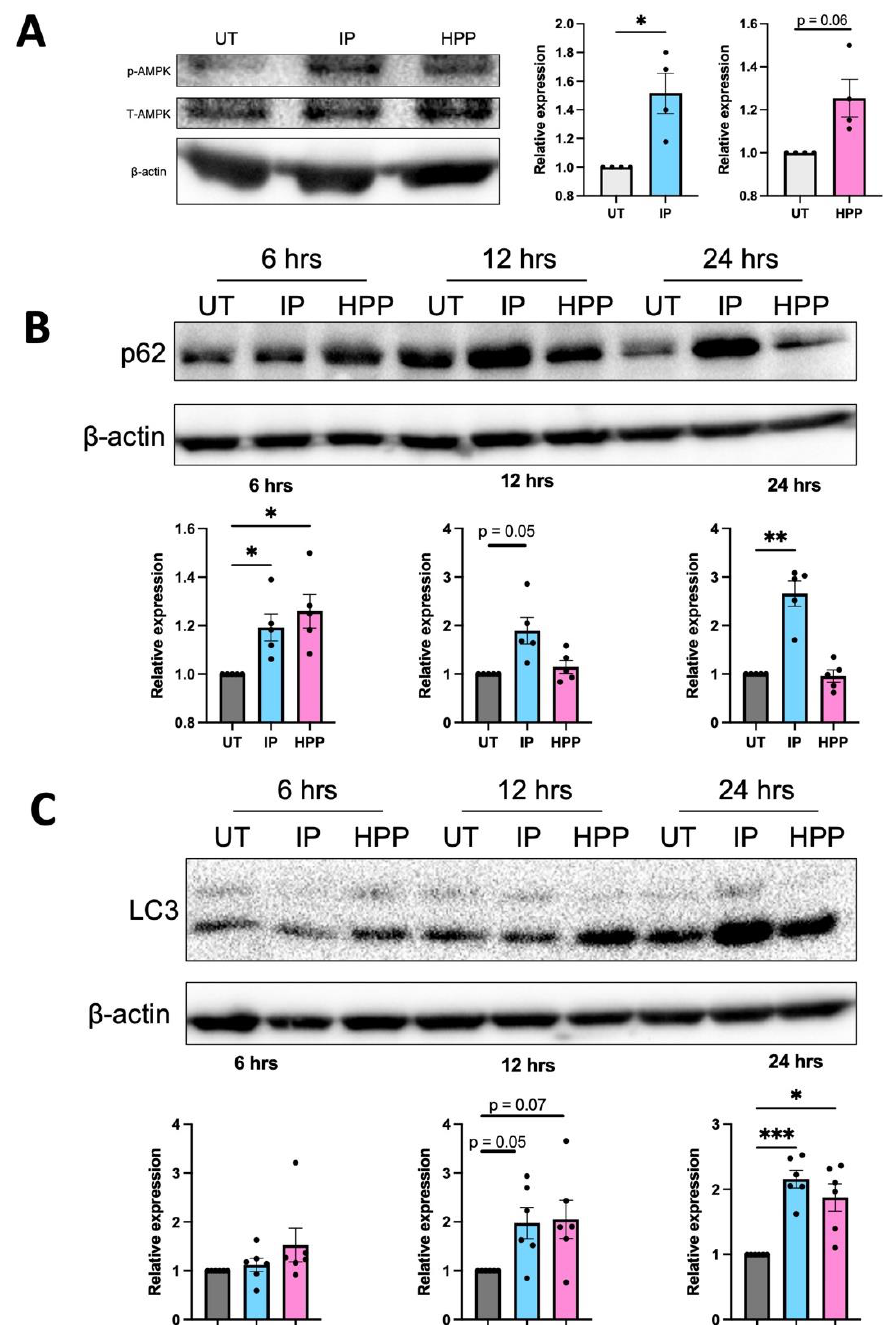
Figure 6. HPP and IP modulate autophagy-related proteins. ( A ) Primary human DC were left untreated (UT) or incubated with IP or HPP at 1000 µ M for 15 min. Phosphorylation of AMPK was measured by western blot. Densitometry results shown are mean ± SEM of the relative expression of p-AMPK: β -actin from four healthy donors. ( B , C ) Primary human DC were left UT or incubated with IP or HPP at 1000 µ M for 6, 12, or 24 h. Expression of ( B ) p62 and ( C ) LC3 were measured by western blot. Densitometry results shown are mean ± SEM of the relative expression of ( B ) p62: β -actin from five healthy donors and ( C ) LC3 II: β -actin from six healthy donors. ( A ) Statistical significance was determined using a Paired t -test. ( B , C ) Statistical significance was determined by repeated measures one-way ANOVA with Dunnett’s multiple comparisons post hoc test to compare means of treatment groups to the control group (*** p < 0.001, ** p < 0.01, * p < 0.05). ImageLab (Bio-Rad) software was used to perform densitometric analysis.